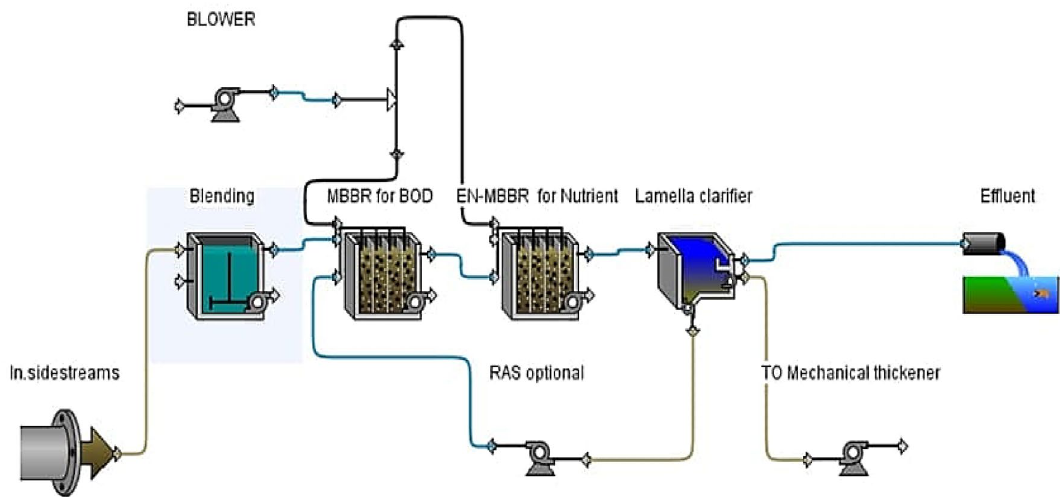
Figure 2. Schematic diagram of novel EN-MBBR